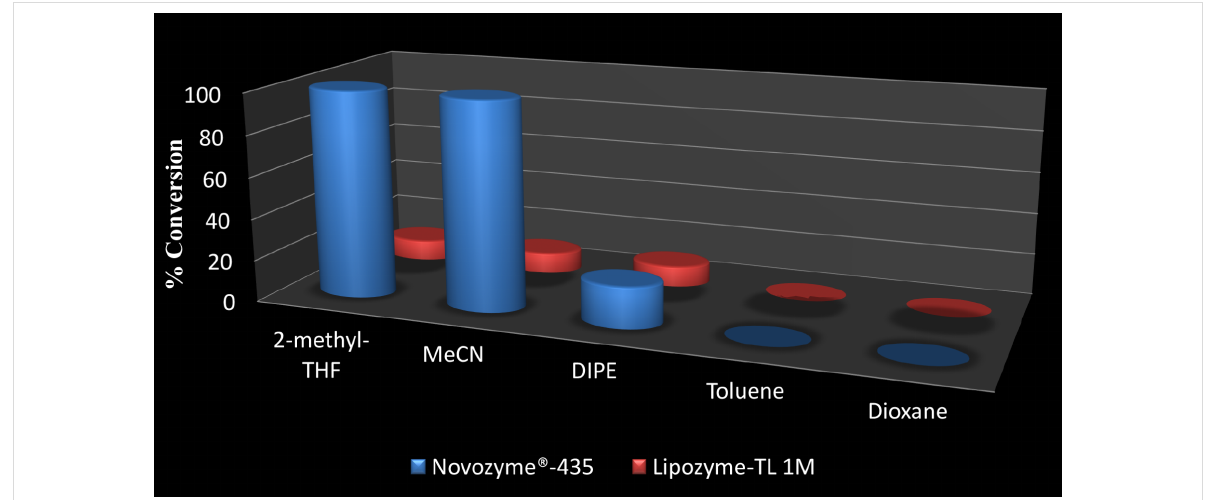
Figure 1: Screening of Novozyme ® -435 and Lipozyme TL IM in different organic solvents at 35 °C for regioselective acetylation of trihydroxyribo / xylo- furanose 3a and 3b (none of the reactions yielded any product when performed in the absence of the enzyme).